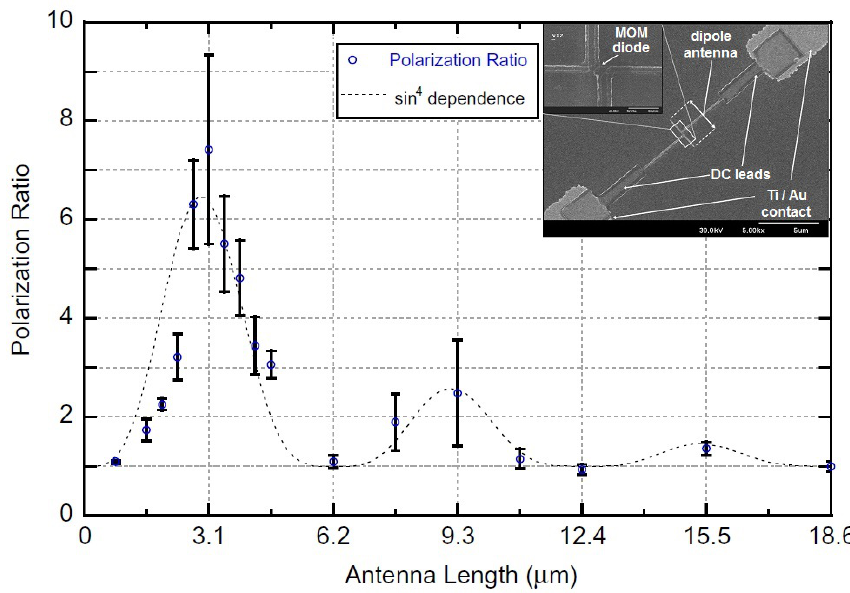
Figure 5. Polarization ratio of Al/AlOx/Pt ACMOMD as a function of the length of the dipole antenna [1].